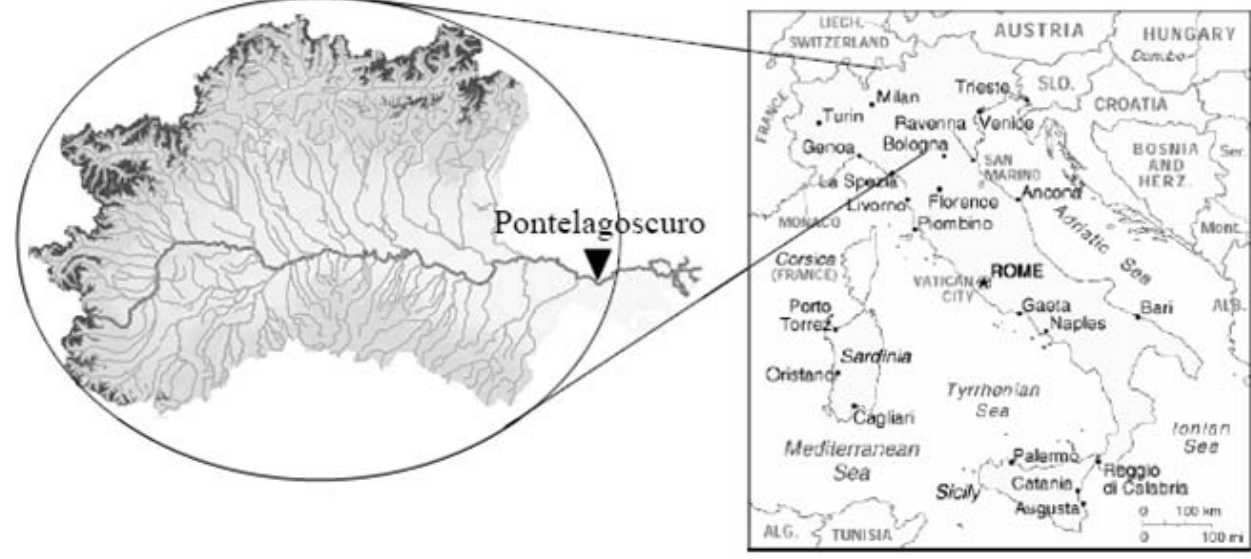
Fig. 5. The River Po catchment in Italy and the location of the gauging station of Pontelagoscuro.